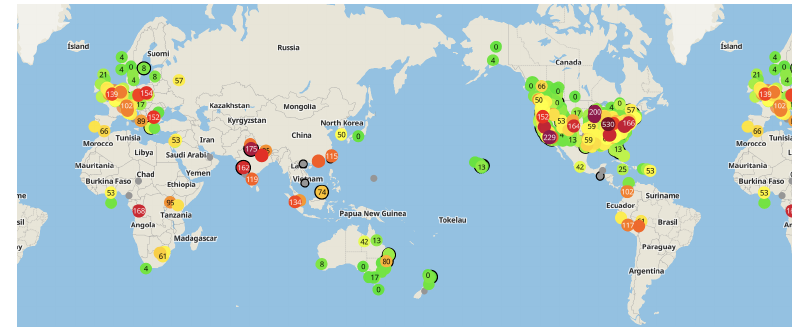
Figure 2. Screenshot from the a.com Map in reference for application popularity.